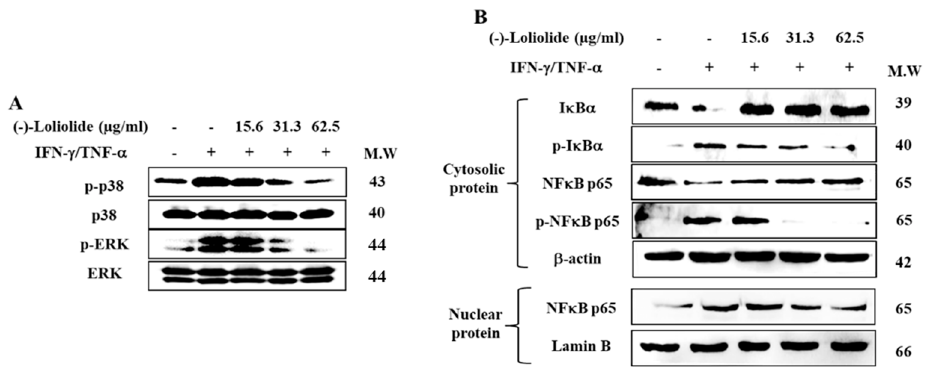
Figure 4. Inhibitory effects of (–)-loliolide on IFN- γ /TNF- α -induced activation of MAPK ( A ) and NF- κ B ( B ) signaling in HaCaT keratinocytes.